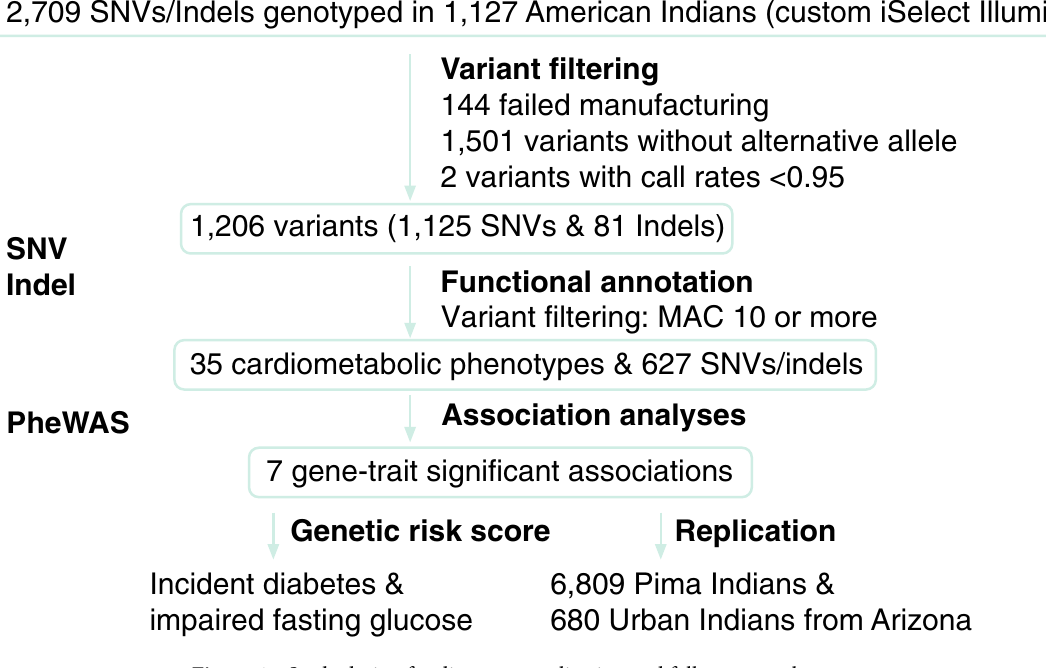
Figure 1. Study design for discovery, replication and follow-up